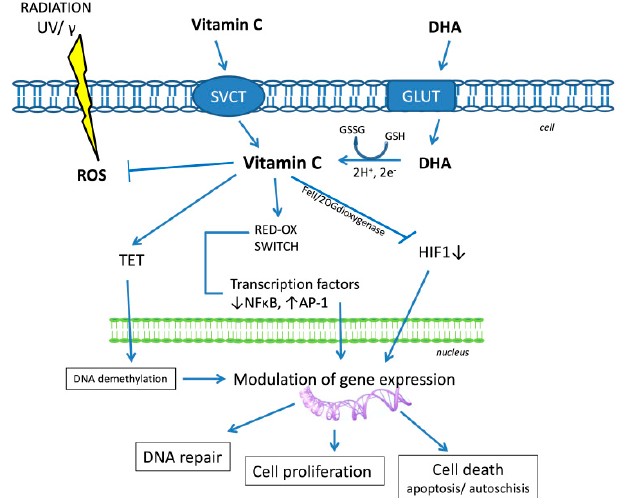
Figure 4. Biological function of vitamin C according to [15,21,23,44,47]. SVCT, sodium-dependent